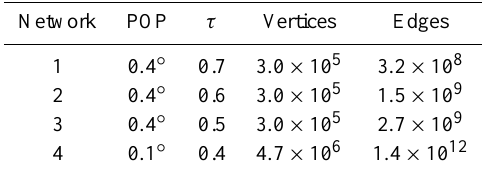
Table 1. Different threshold values τ used in the reconstruction of Pearson correlation networks from the 0.4 and 0.1 ◦ POP data sets and corresponding number of network vertices and